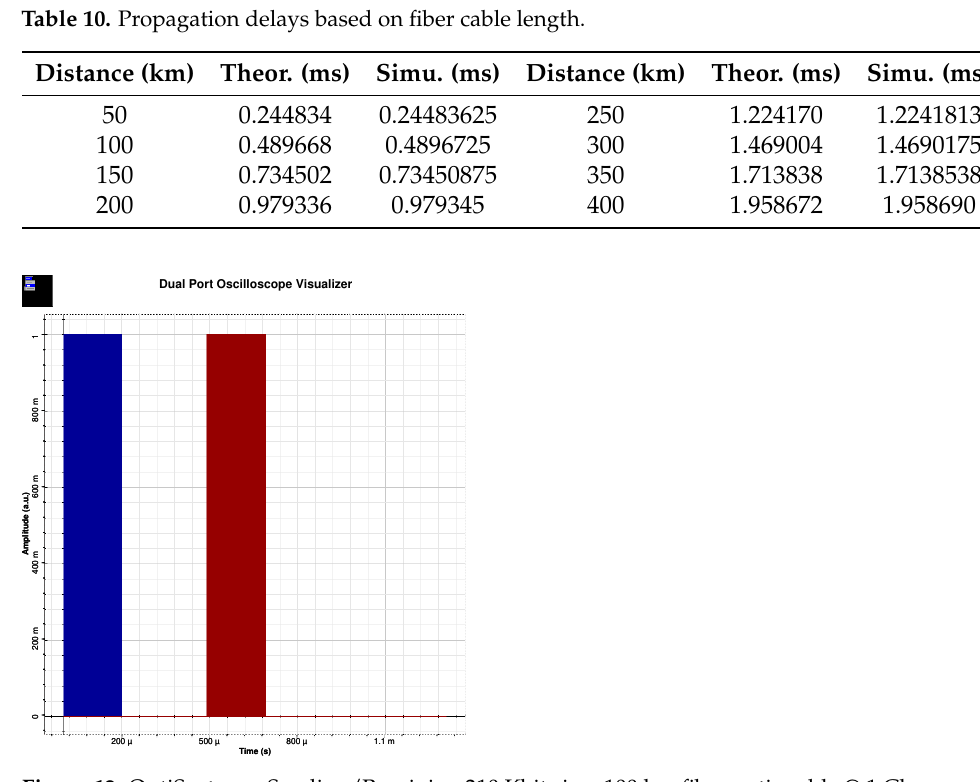
Figure 12. OptiSystems: Sending/Receiving 210 Kbits in a 100 km fiber optic cable @ 1 Gbps. Figure 13 shows a schematic of a 100 km fiber optic P2P communication link in OptiSystems. It shows the transmitter (IED), receiver (Data concentrator), and multiple optical blocks. Each block represents an optical amplifier and 25 km fiber cable.